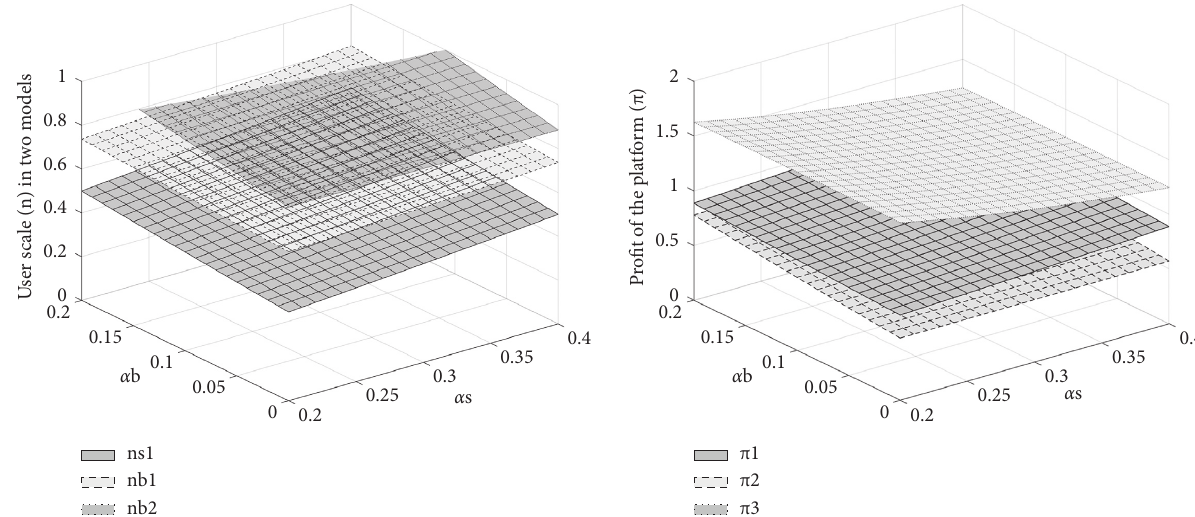
Figure 2: The impact of intergroup network externality on user scale and profits.